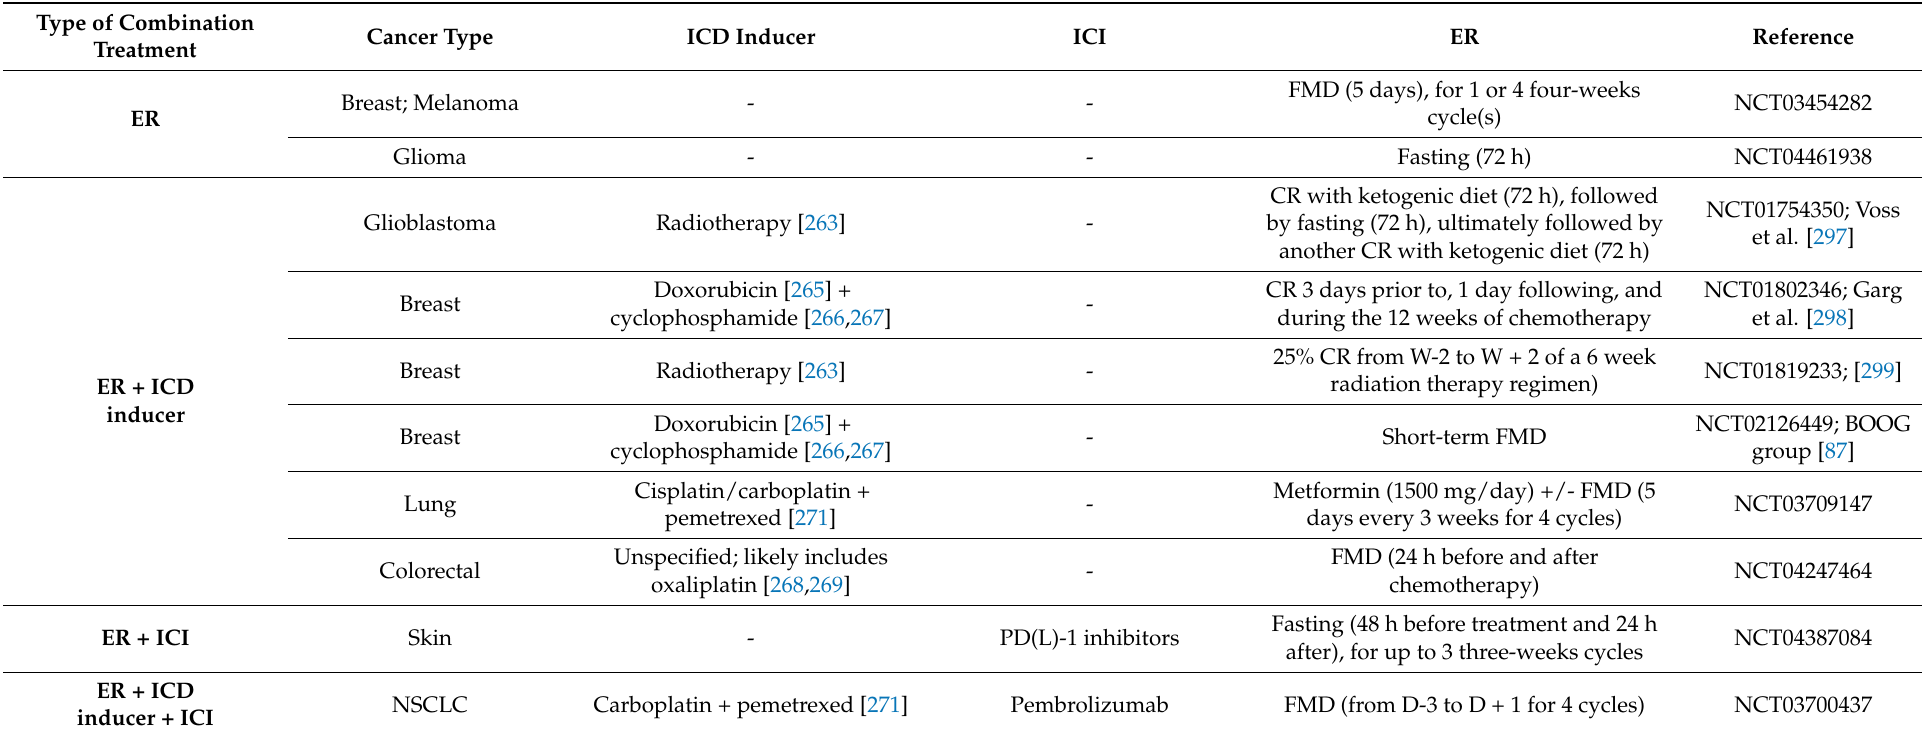
Table 3. Ongoing clinical trials listed on clinicaltrials.gov investigating ER-mediated metabolic reprogramming alone or as an adjuvant to immunotherapy, ensured by ICD inducers and/or